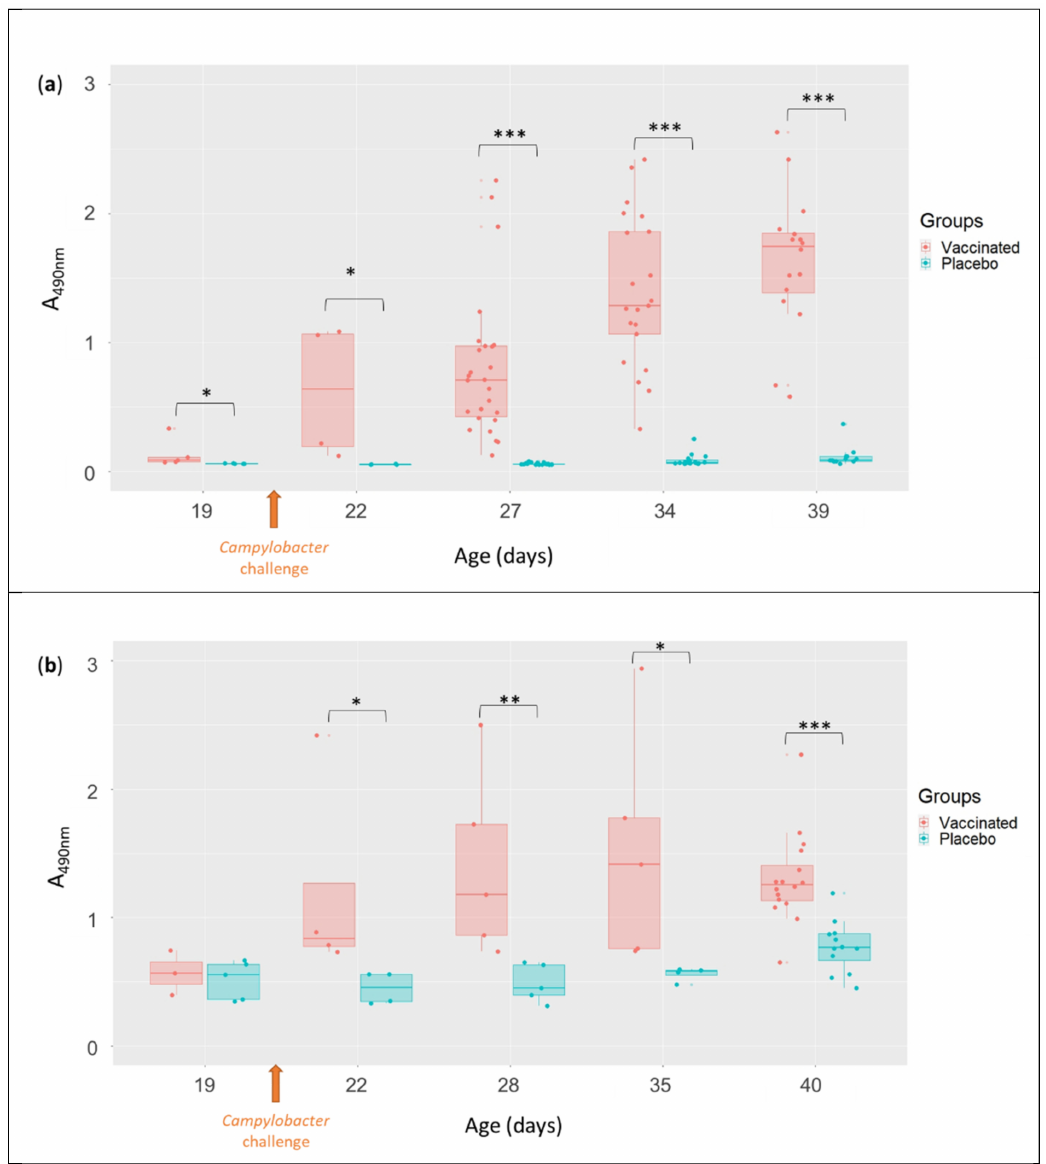
Figure 3. Anti-flagellin antibody levels after vaccination and challenge. ( a ) Levels of anti-flagellin IgY antibodies in serum. ( b ) Levels of anti-flagellin IgA antibodies in bile. Significant differences between the two groups are indicated by asterisks (* p < 0.05, ** p < 0.01, *** p < 0.001; Wilcoxon rank sum